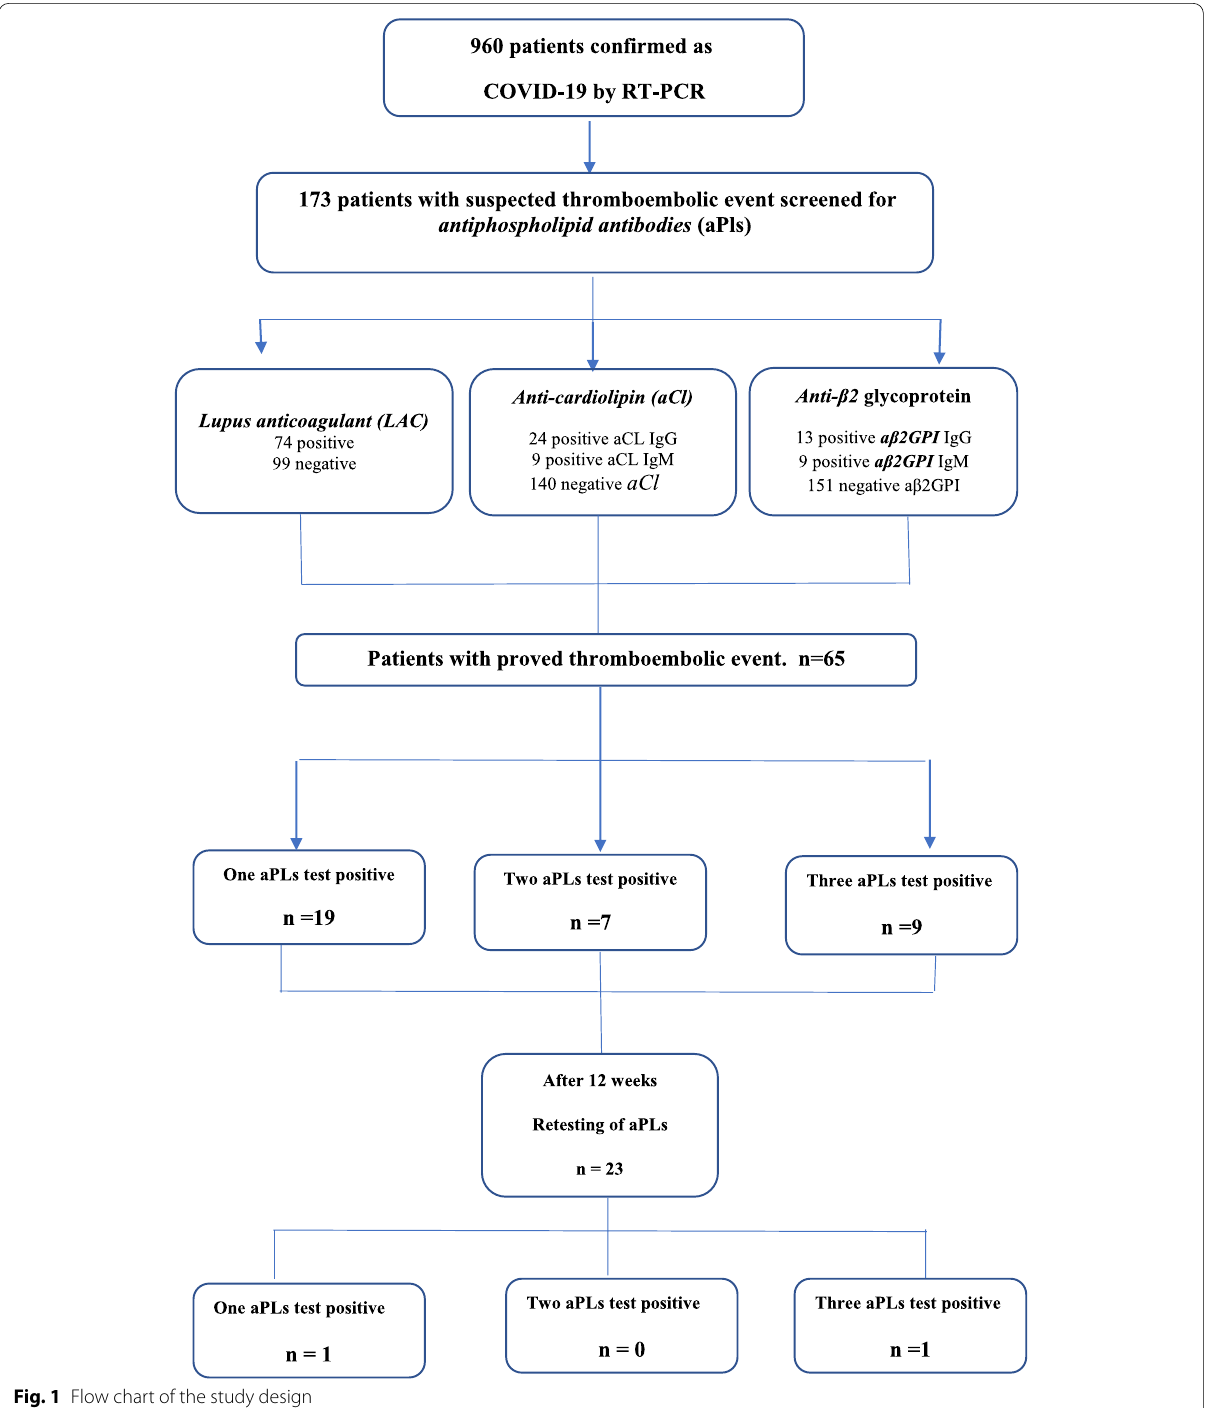
Fig. 1 Flow chart of the study